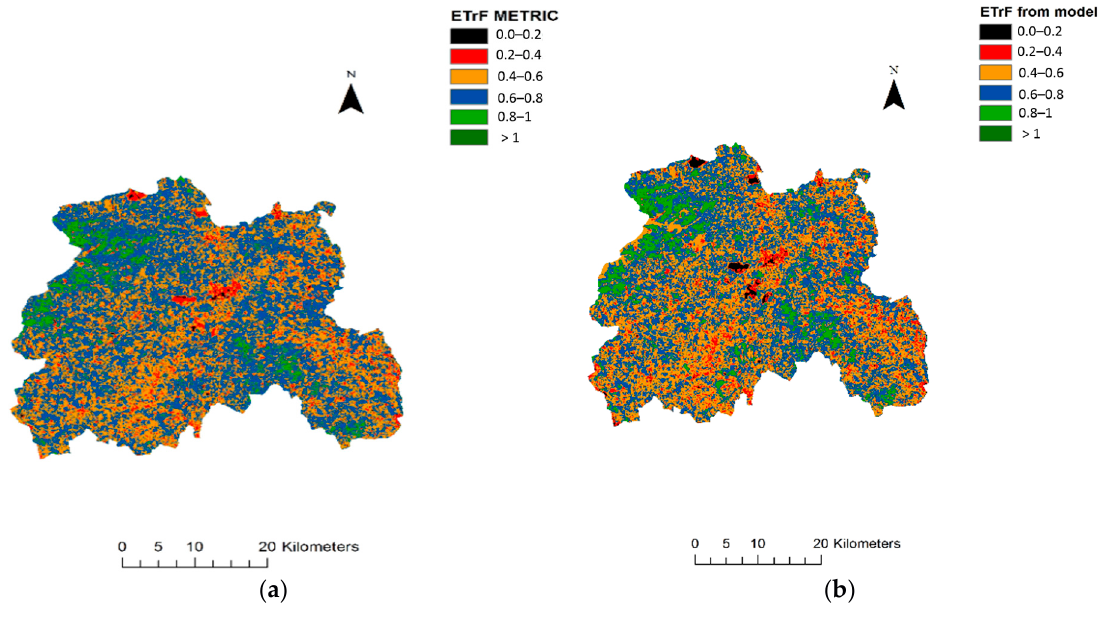
Figure 7. ET r F maps of 12 July 2013 at Laois Co: ( a ) METRIC based; and ( b ) O’Connell based.